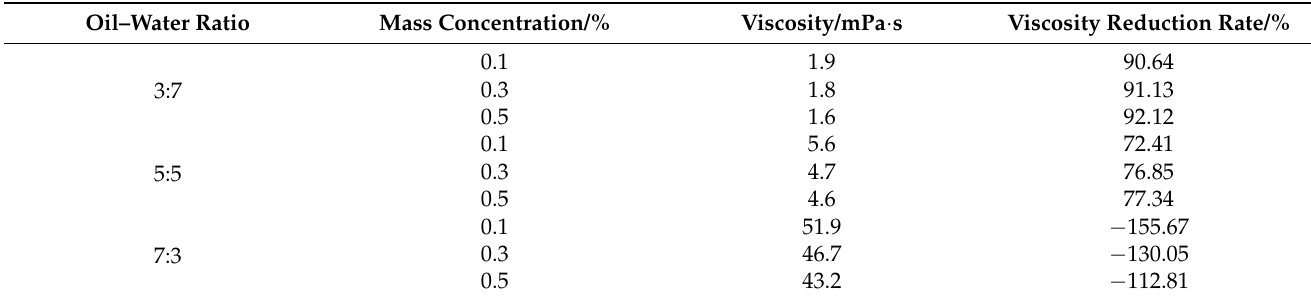
Table 2. Viscosity reduction results for 2# with different oil–water ratios.